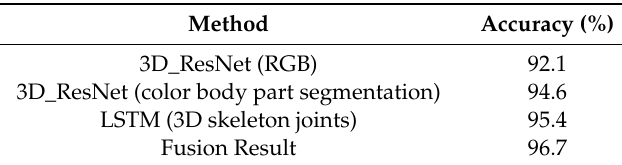
Table 3. Gesture classification performance in each modality and the fusion result on the UTD multimodal human action